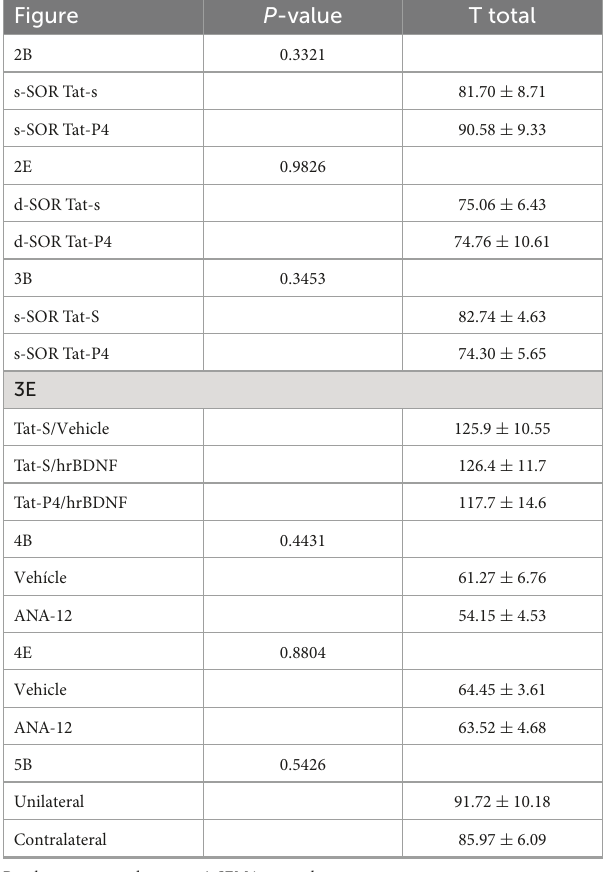
TABLE 1 Total exploration times during the choice session of the SOR task. Figure